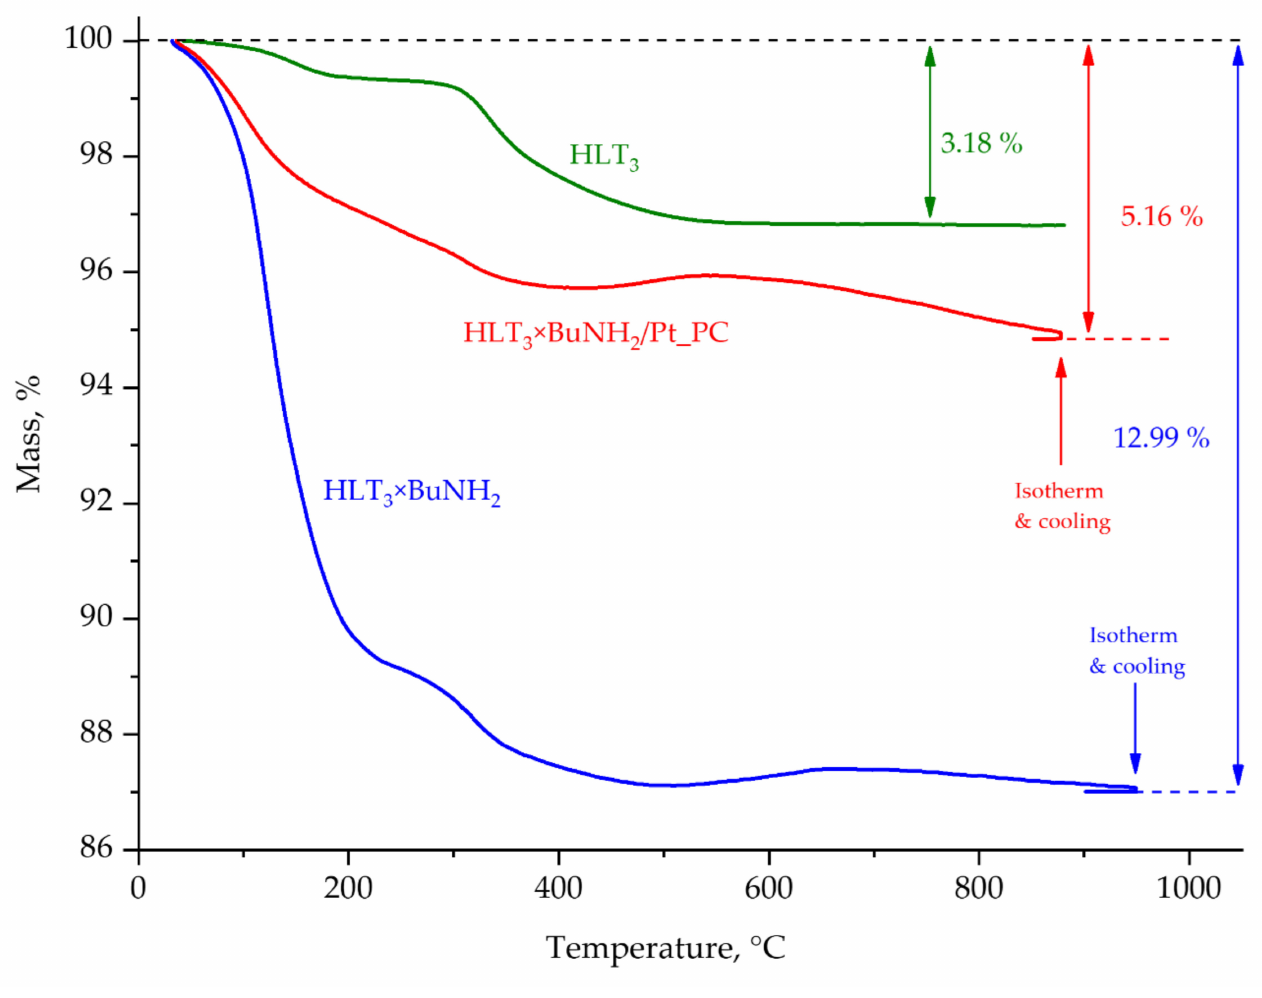
Figure 2. Thermogravimetric curves for the protonated titanate (HLT 3 ), its n -butylamine-intercalated form (HLT 3 × BuNH 2 ) and the platinized n -butylamine-intercalated form after photocatalytic experi- ment (HLT 3 × BuNH 2